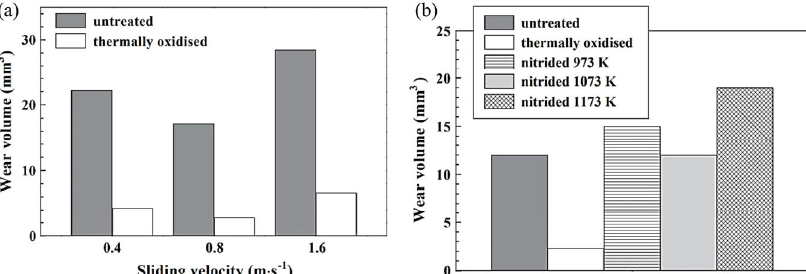
Fig. 6 Wear behavior of processed Ti64 specimens (U-Ti64, ThO-Ti64, N-Ti64) at different block-sliding conditions: (a) coupling load = 50 N and sliding distance = 3,000 m; (b) coupling load =50 N, sliding velocity = 0.8 m·s − 1 , and sliding distance = 1,700 m. Reproduced with permission from Ref. [26]. Copyright Elsevier, 2005.